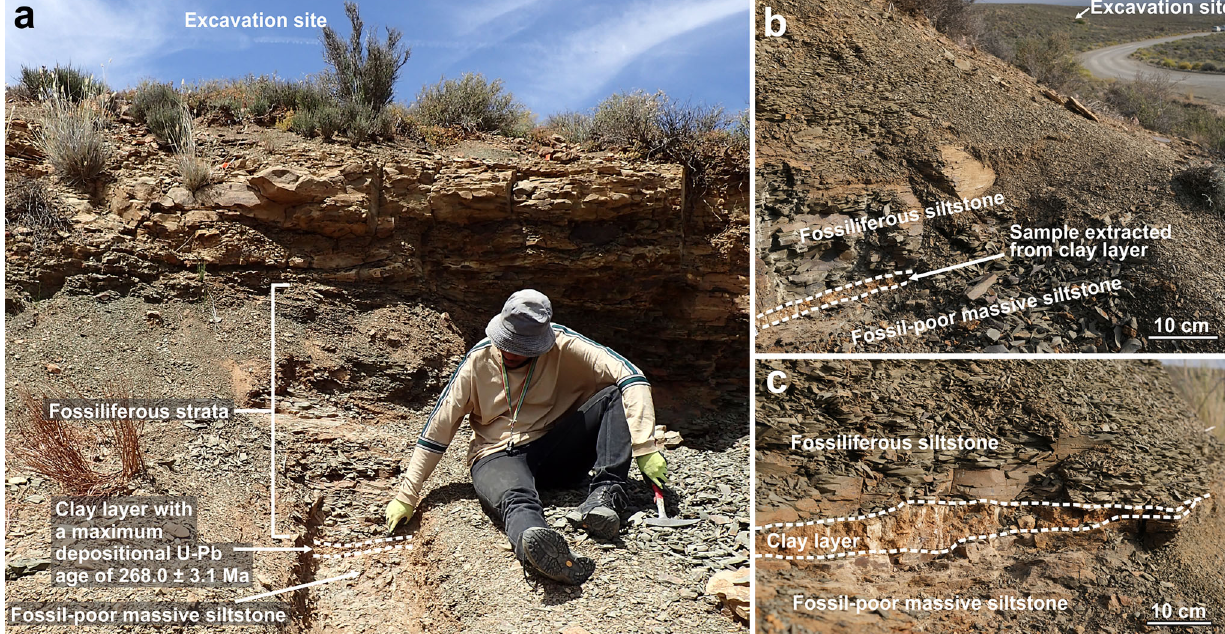
Fig. 3 Onder Karoo fossil locality. a Abandoned quarry exposing fossiliferous siltstones that have being excavated and an underlying clay layer that has a maximum depositional U-Pb age of 268.0 ± 3.1 Ma (see Supplementary Note 2 for detailed explanation and Supplementary Data 1). b Sporadically exposed clay layer 200 m NE of the excavation site where a fresh sample was extracted. c Clay layer where locally more prominent, 180 m NE of the excavation